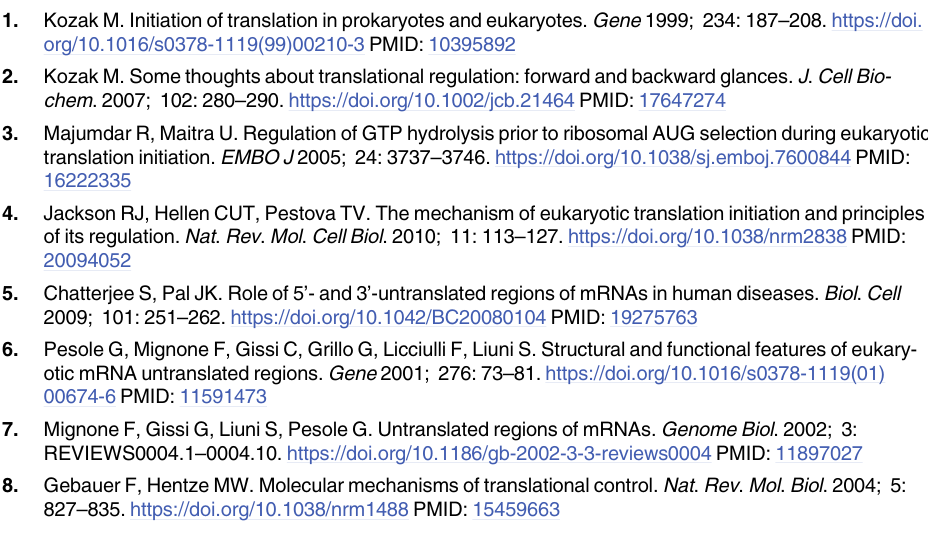
S3 Fig. Analysis of integrity of the reporter mRNA during rice suspension culture proto- plast incubation. mRNA for the reporters were obtained by RT-PCR immediately after testing their translation efficiencies. cDNA was amplified using primers corresponding the entire 5’UTR region and the GUS coding region. From left to right: cDNA (UTRc) contains the con- trol DNA fragment amplified from the wild-type UTRc; UTRc indicates the transcript ampli- fied from the wild-type UTRc construct; "Complementary", "Restored-interaction", and "Tuncation" shows corresponding mutant transcripts described in Fig 6. A Gap is introduced between the lanes of the same gel. Size markers used are 100 bp DNA ladder marker (New England Biolabs, Ipswich, MA,